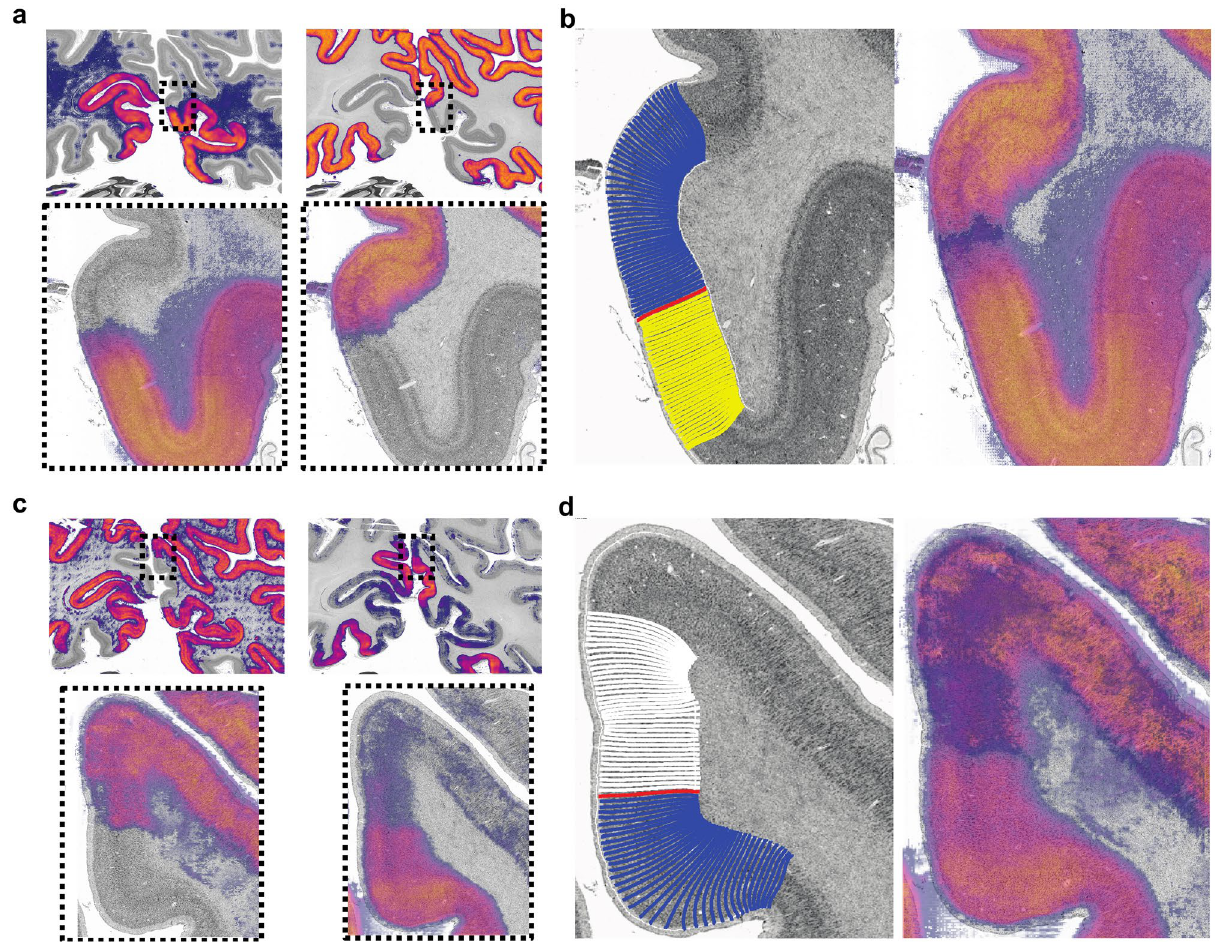
Figure 7. Third level filter activations of the hOc1 ( a , b ) and hOc2 ( c , d ) CNN. Images in ( a ) and ( c ) show two contrasting third level filter activations from network layer 23 of the hOc1 ( a ) and hOc2 ( c ) CNNs on the validation section (section 1021). The images in ( b ) and ( d ) compare the border detection result of the GLI profile approach (left) with the combined overlays of the two contrasting third level filter activations